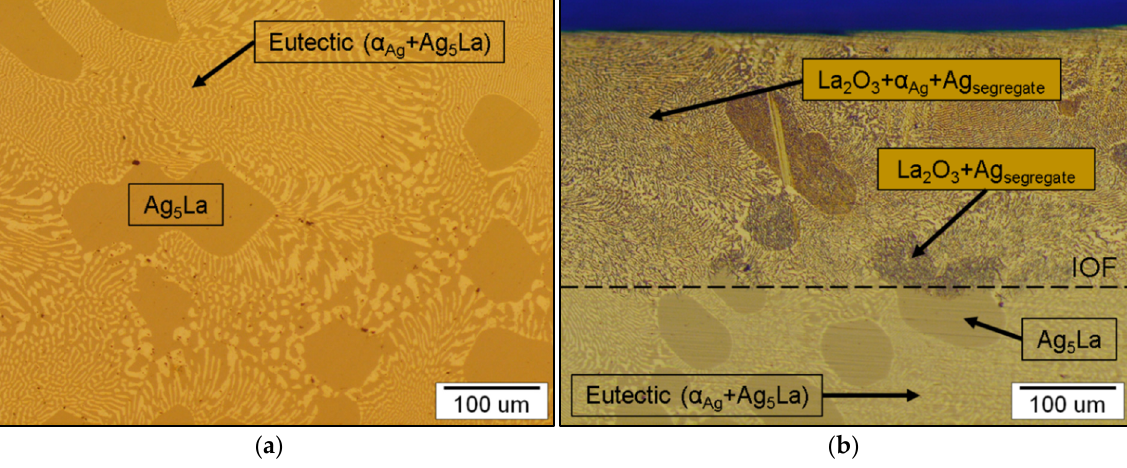
Figure 11. Microstructure of the cast hypereutectic composition of Ag-14 wt.% La: ( a ) as cast; ( b ) after partial internal oxidation, with a visible Internal Oxidation Front (IOF). partial internal oxidation, with a visible Internal Oxidation Front